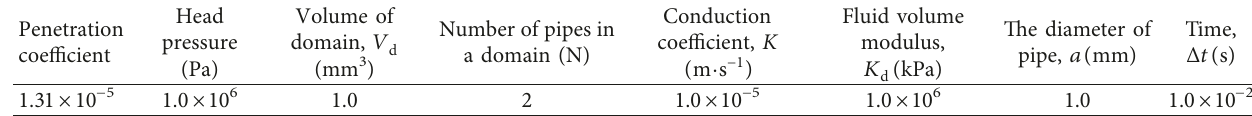
Table 3: Microparameters of fluid.